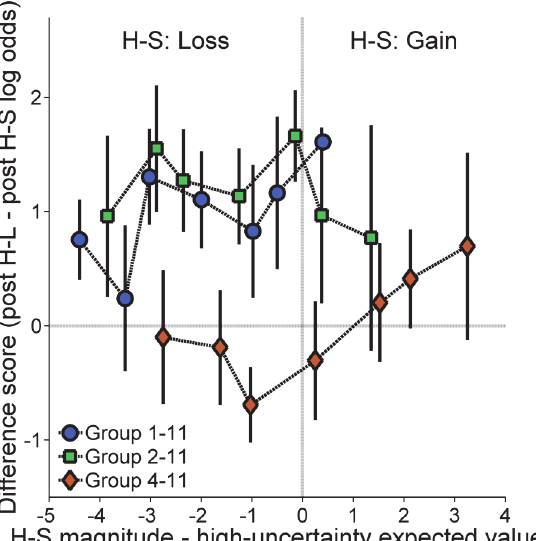
Fig 3. Mean ( ± SEM) difference score between the log odds of high-uncertainty choices following high- uncertainty-large (H-L) outcomes and the log odds of high-uncertainty choices following high- uncertainty-small (H-S) outcomes for each group in Experiment 1 as a function of the difference between the magnitude of the H-S outcome and the expected value of the high-uncertainty choice. A negative/positive difference on the abscissa indicates that the H-S outcome magnitude was greater than/less than the expected value of the high-uncertainty choice (gain/loss, respectively). A negative or positive difference on the ordinate reflects a greater likelihood to make high-uncertainty choices following H-S or H-L outcomes, respectively.